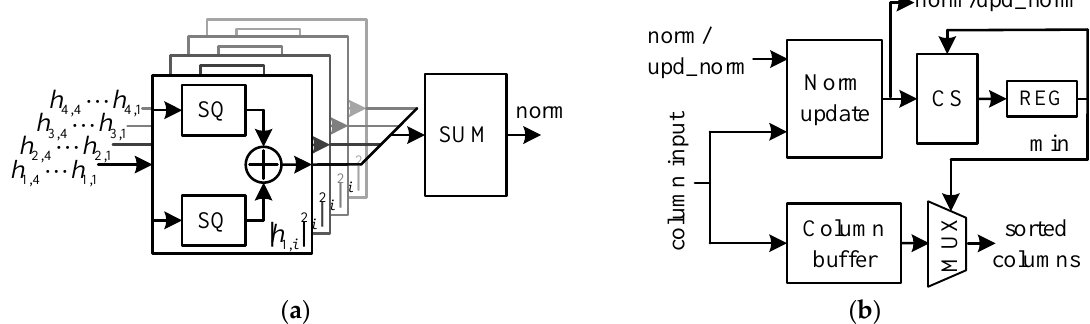
Figure 13. Architecture of the modules of the iterative sorting procedure: ( a ) norm calculator; ( b ) sorting#1–3.